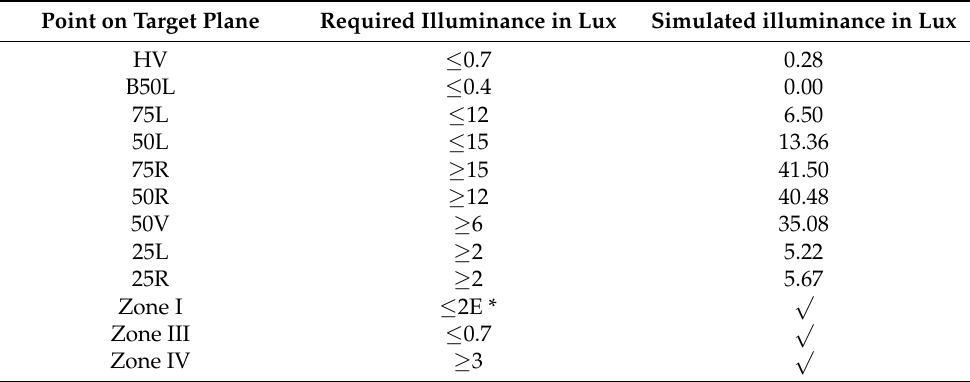
Figure 17. ( a ) The color distribution of high beam with a prism and ( b ) without a prism.